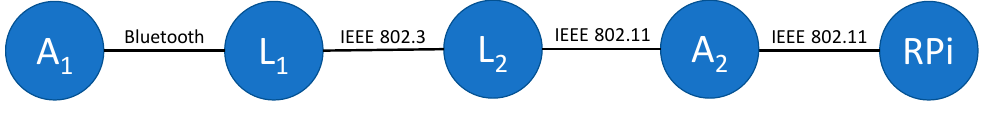
Figure 6. Four-hop deployment scenario.